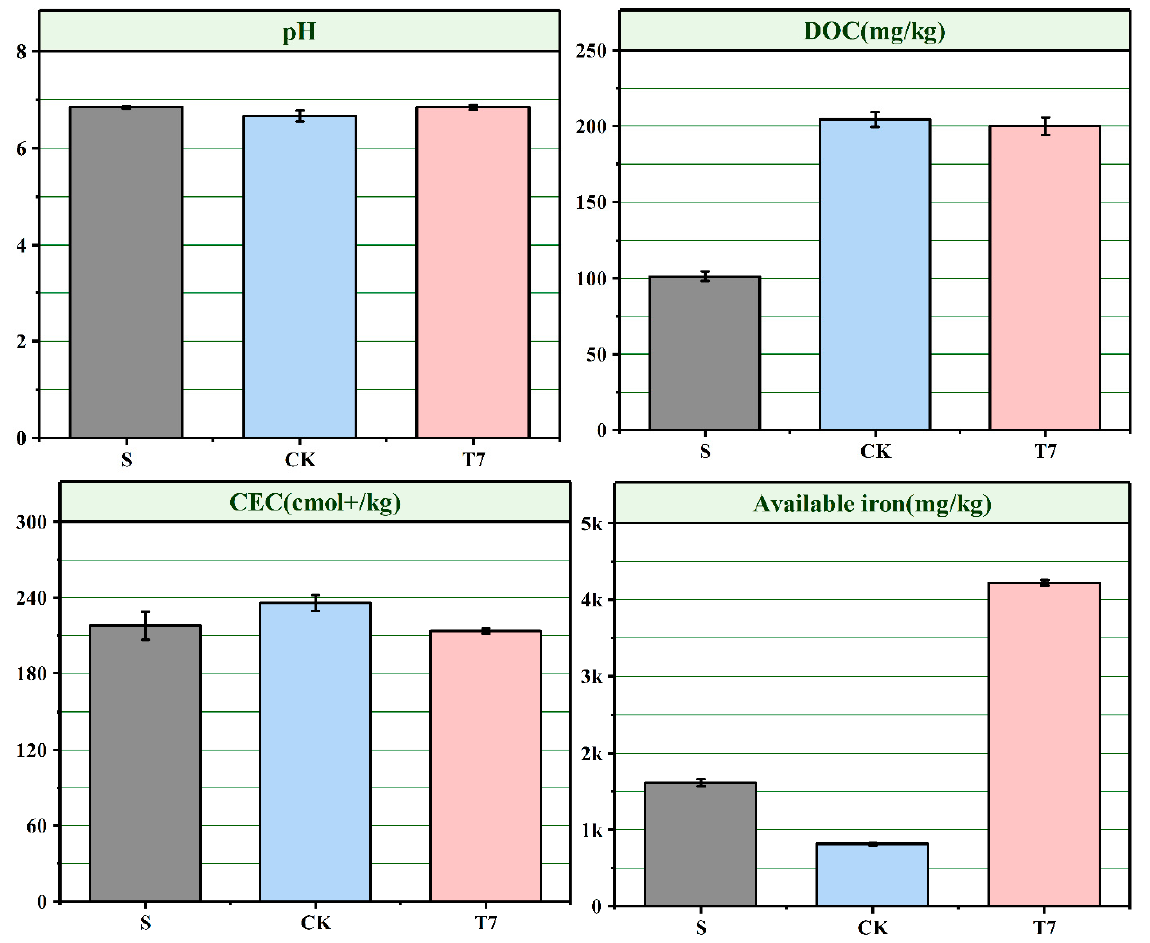
Figure 7. Effect of BC-nZVI on soil properties. (Unactivated original contaminated soil (S), soil without any additive (CK), BC-nZVI, 10 g/kg (T7)).